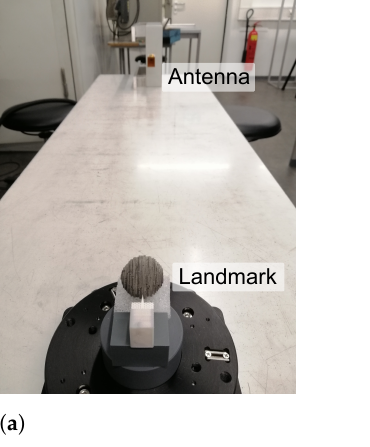
Figure 10. Cluttered set-up for high-Q landmark. ( a ) Clutter set-up for high-Q tag. ( b ) Closer view on the moving clutter